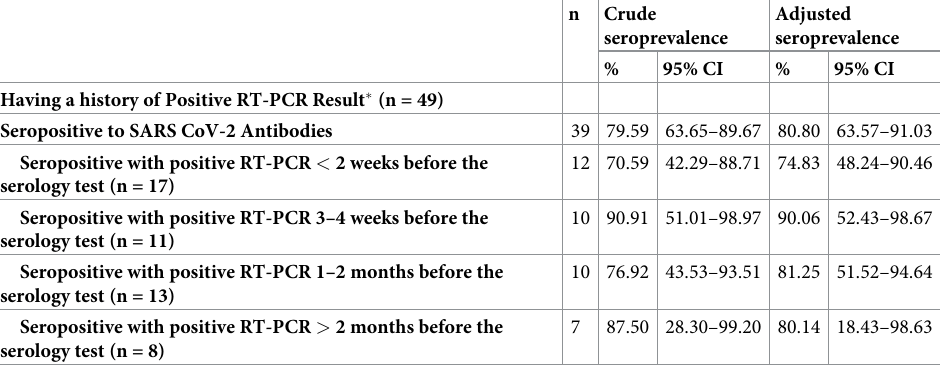
n Crude Adjusted seroprevalence seroprevalence % 95% CI % 95% CI